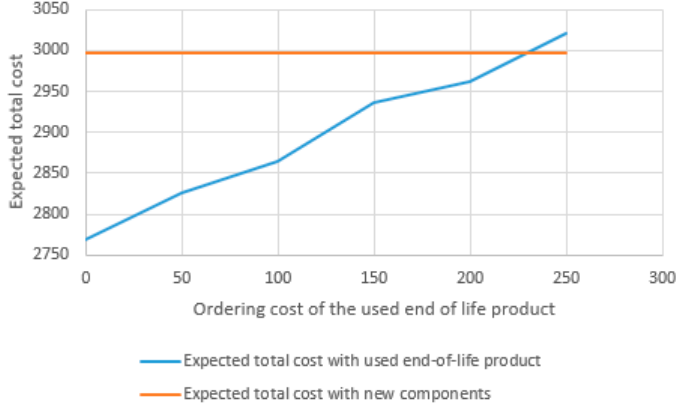
Figure 9. Sensitivity diagram of the unit purchase cost of used/end-of-life